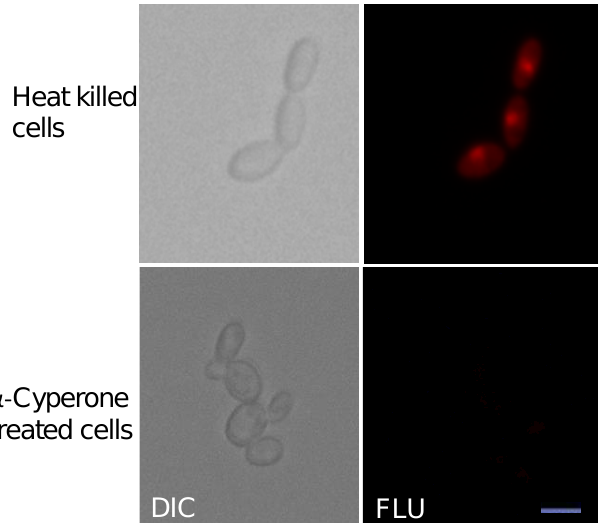
Figure 3. The membrane integrity of C. krusei fungus was unaffected by α -Cyperone. Positive control (heat-killed cells) and α -Cyperone treated (125 µ g/mL) cells were incubated with propidium iodide (PI) fluorescent dye solution as described by the manufacturer (Invitrogen, Carlsbad, CA, USA). Cells were viewed under a fluorescence microscope (Leica DM 6 B) with an appropriate filter. Fluorescent (FLU) images and corresponding differential interference contrast (DIC) images are shown. Scale bar, 10 µm.